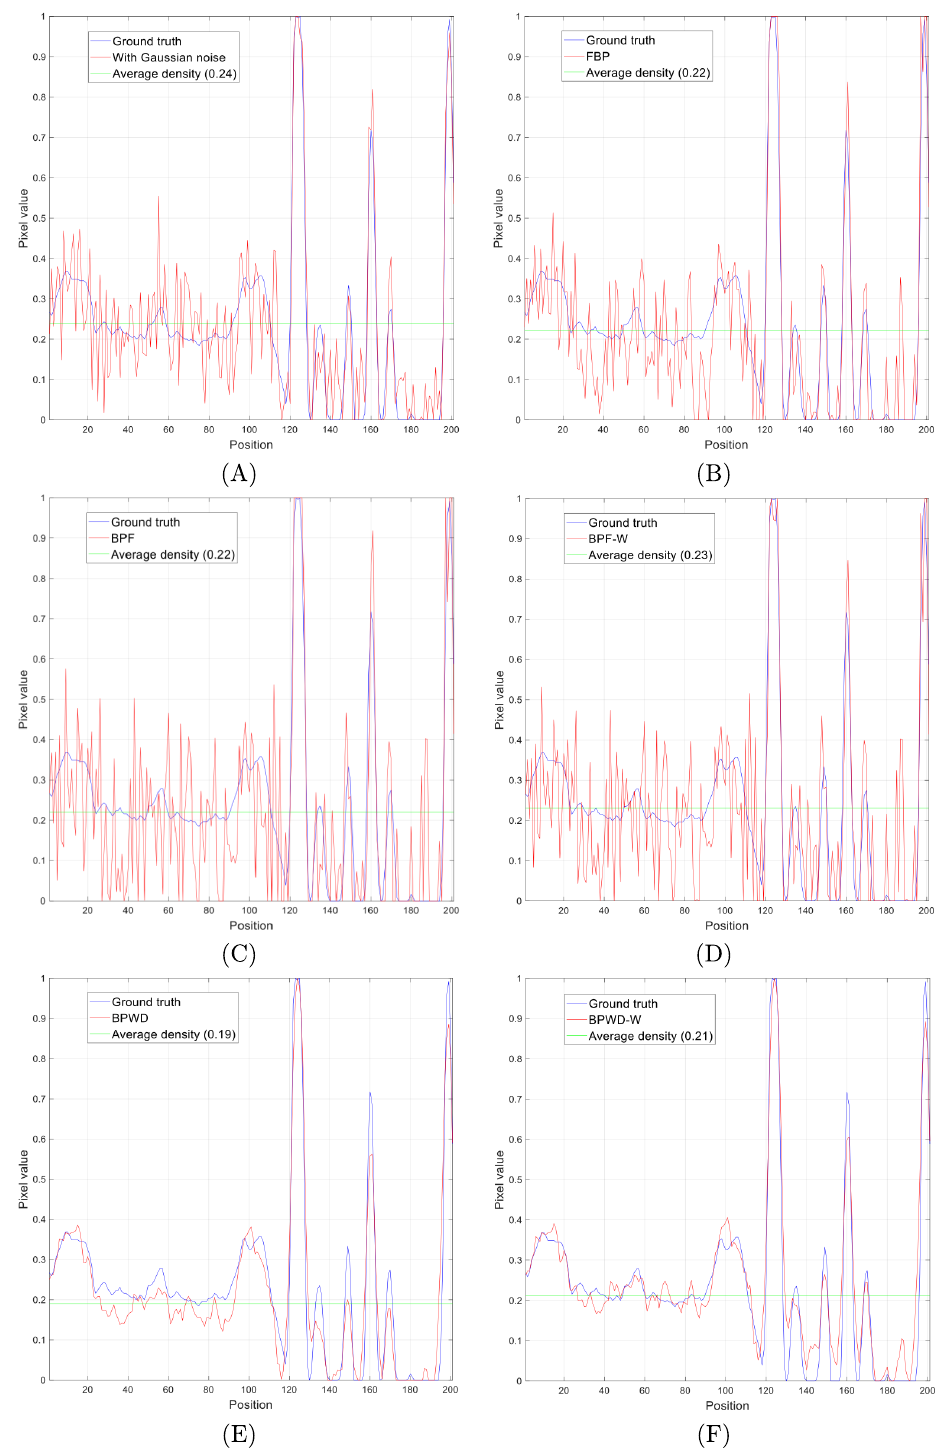
Fig 9. Partial line (indicated by red line in Fig 8) profiles (normalised to the same maximum value) using 180 projections. (A) original image with Gaussian noise; (B) FBP; (C) BPF; (D) BPF-W; (E) BPWD; (F) BPWD-W.